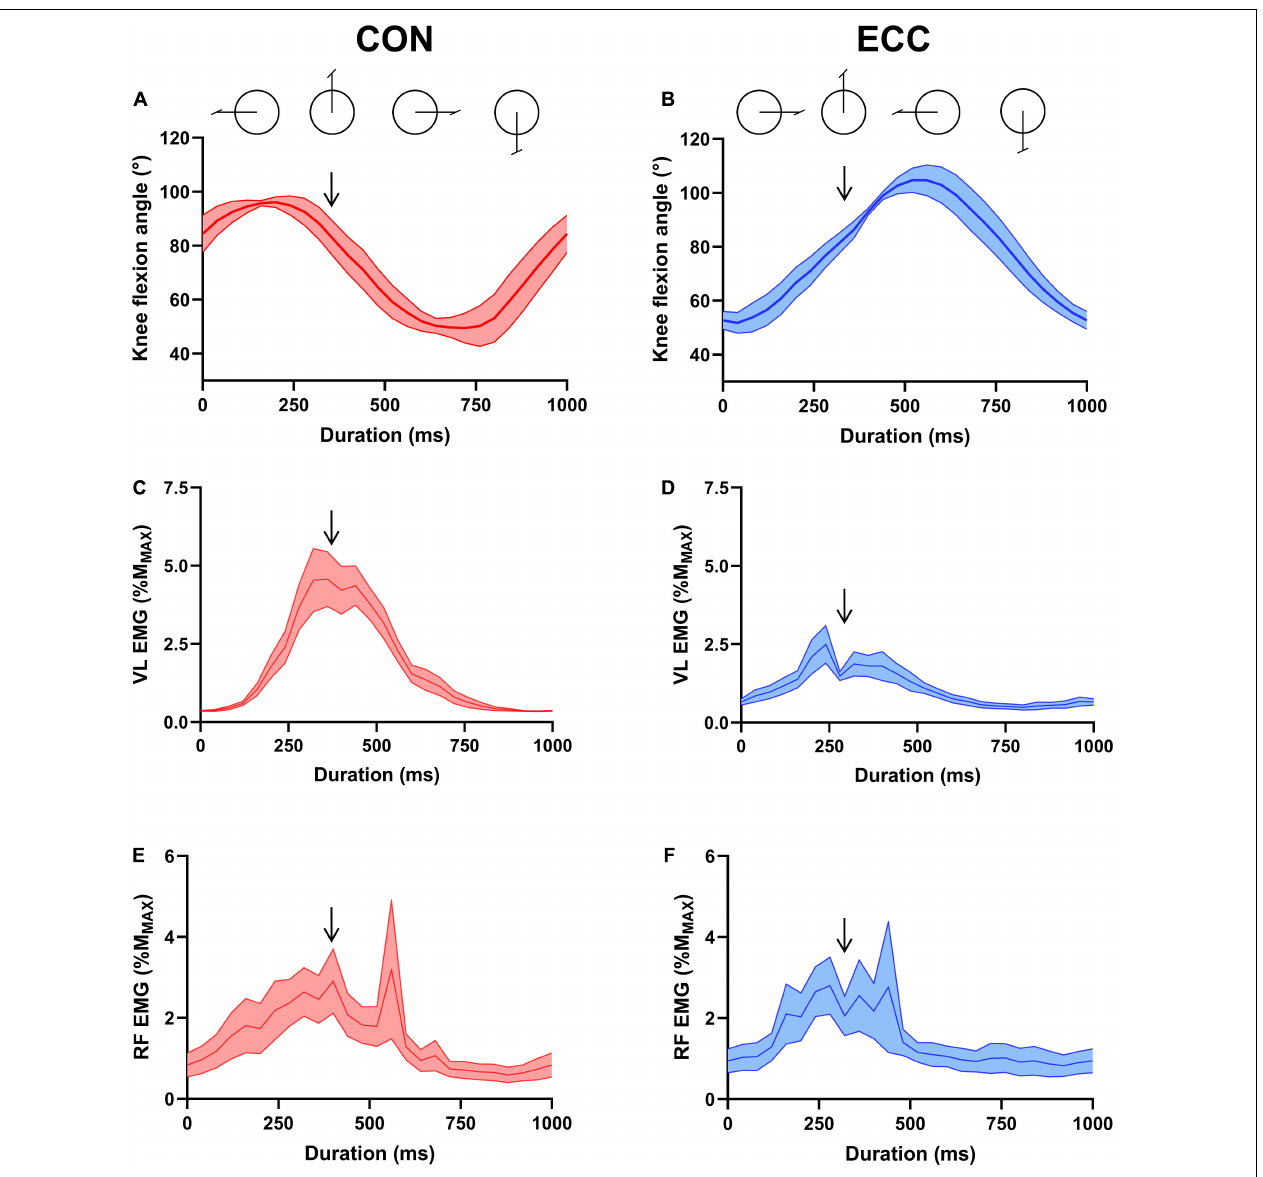
FIGURE 2 | Knee flexion angle and neural drive across a pedaling cycle. (A,B) Illustrate knee flexion angle during concentric (CON) and eccentric (ECC) cycling, respectively. (C) (CON) and (D) (ECC) show vastus lateralis muscle EMG RMS and (E) (CON) and (F) (ECC) represent rectus femoris muscle EMG RMS. All data were obtained at the onset of the strenuous exercises, normalized to the amplitude of the maximal muscle compound (M MAX ) and are represented as mean ± standard error. Downward arrows indicate the moment of peripheral and transcranial stimulations.